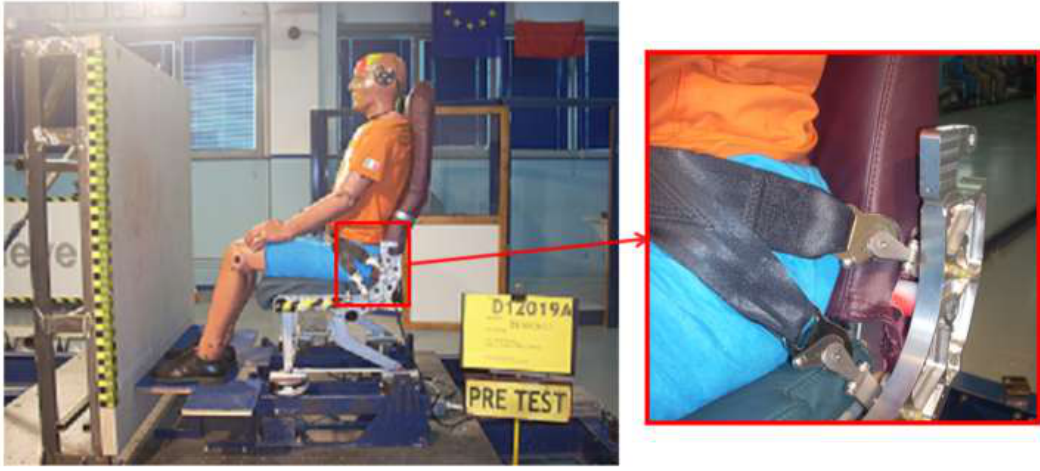
Figure 11. HIC front row experimental test.